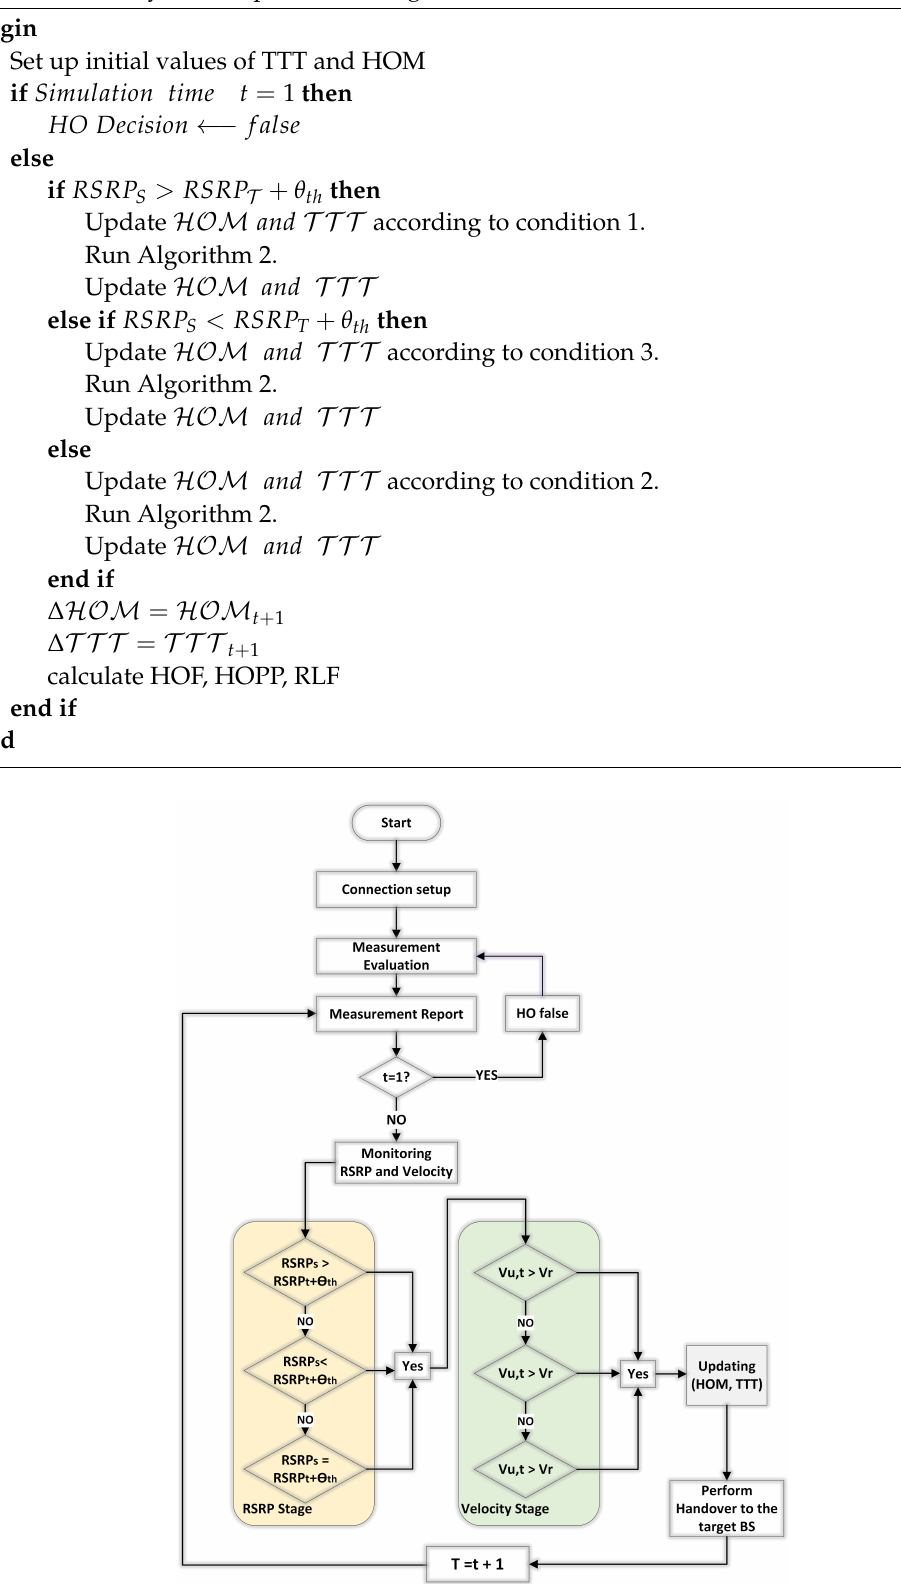
Algorithm 1 Velocity-based optimization algorithm